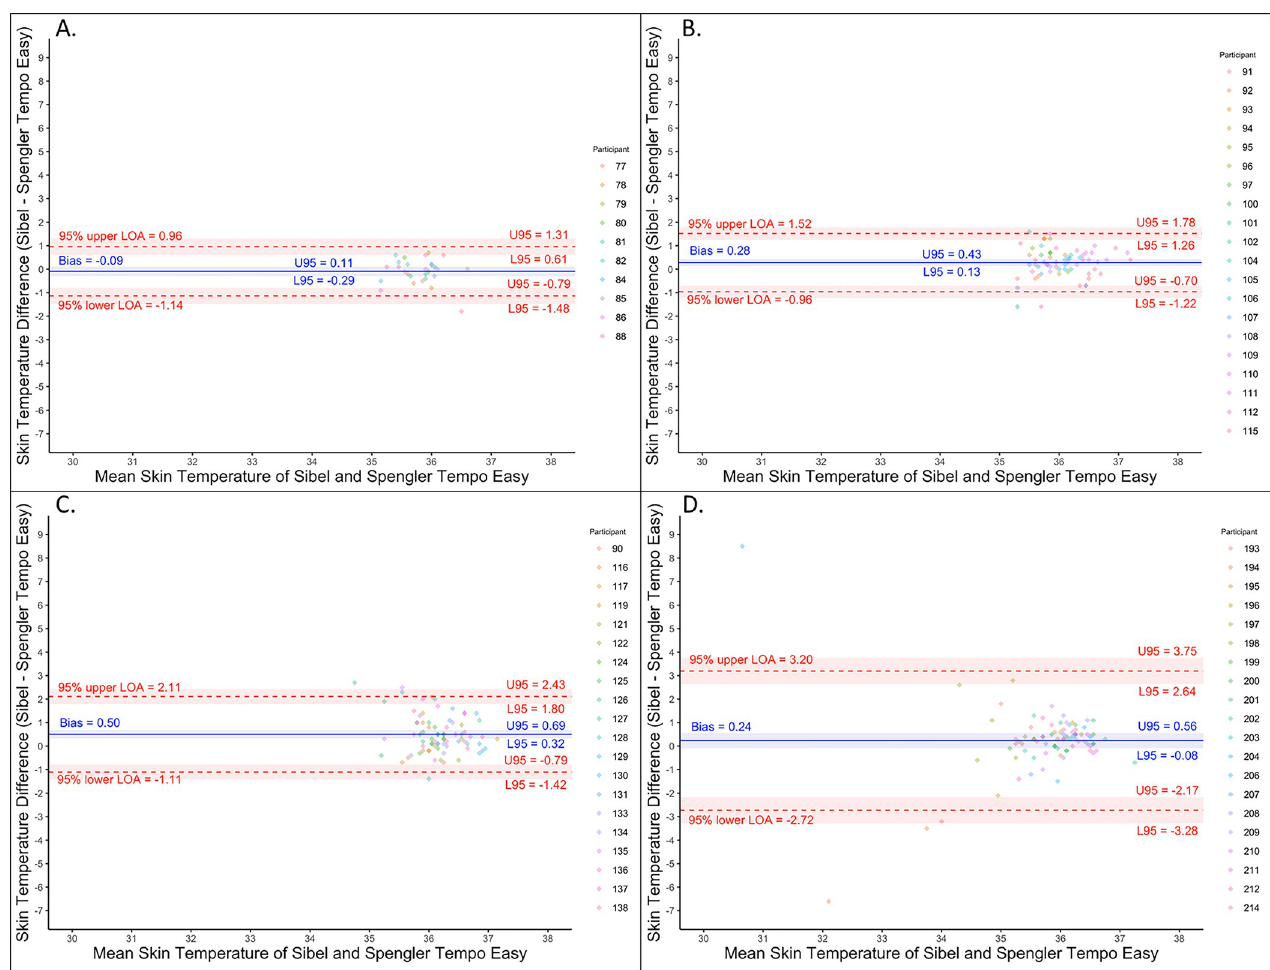
Fig 5. Bland-Altman plots for skin surface temperature. (A) Open-label round. (B) Closed-label round one. (C) Closed-label round two. (D) Closed-label round three. Colors indicate which enrolled neonate is associated with the measurement pair.